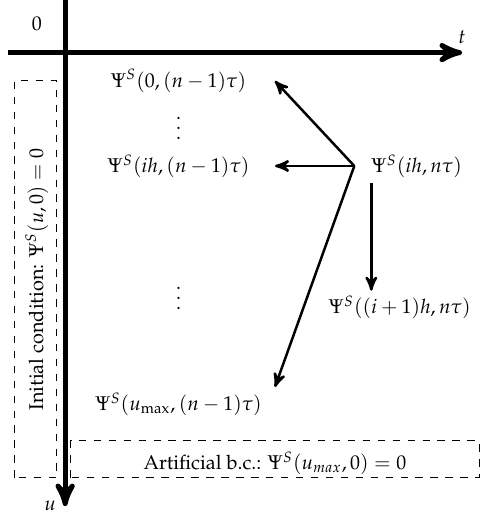
Figure 1. Scheme dependence